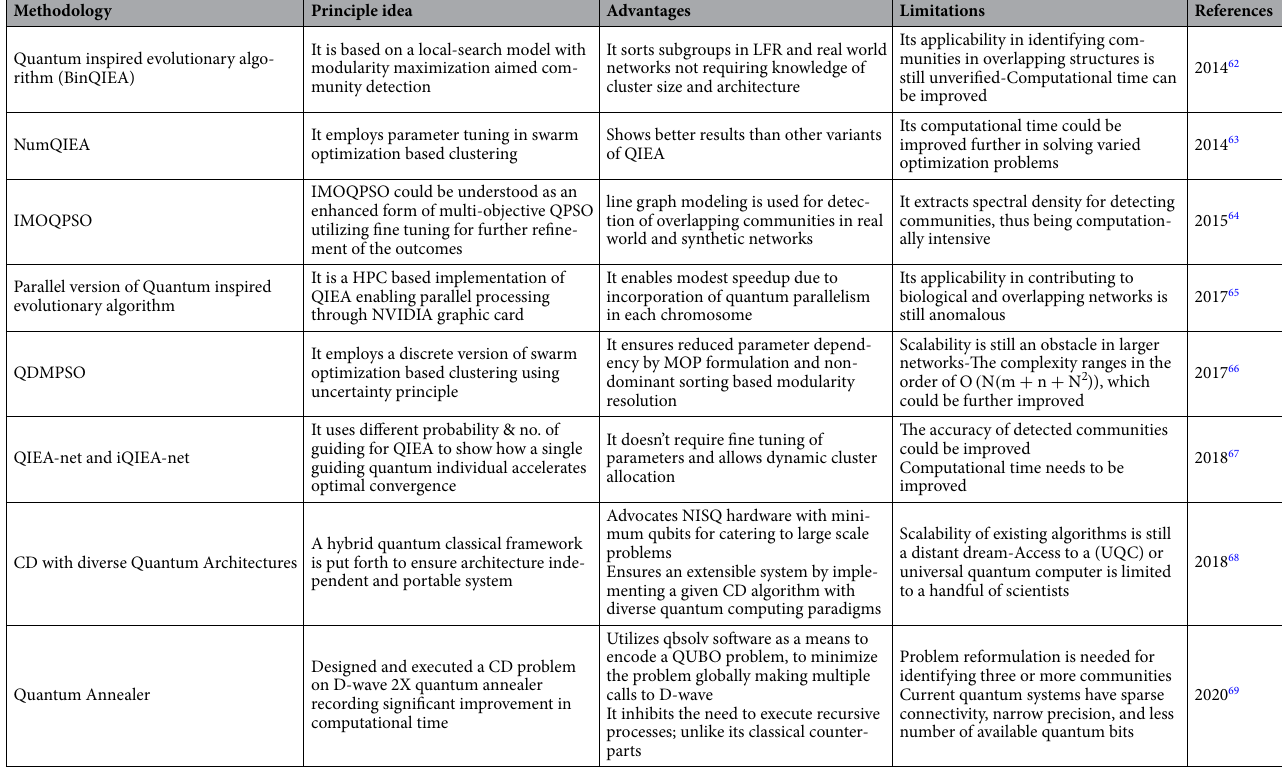
Table 1. Summary of quantum inspired community detection